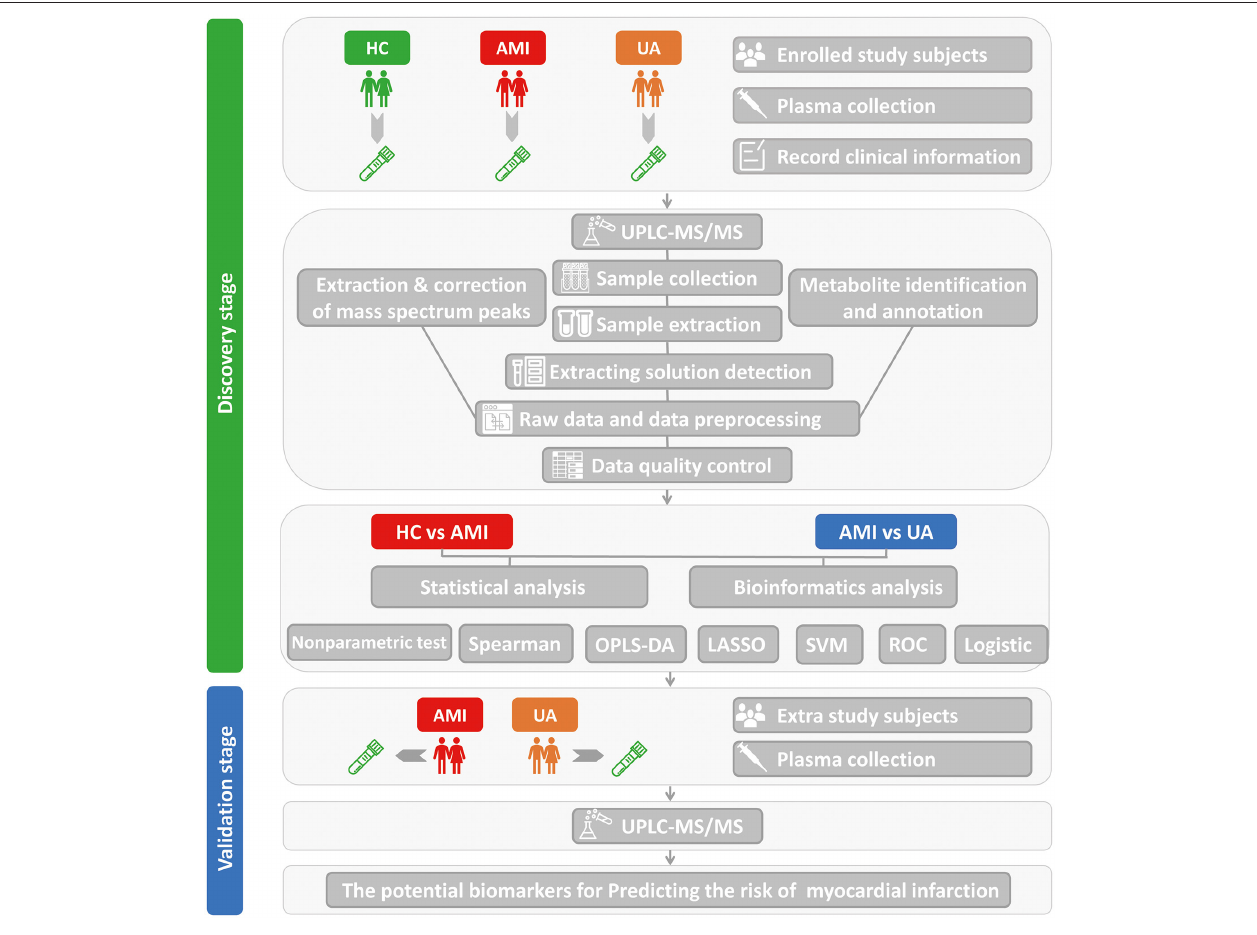
FIGURE 1 | The workflow of this study.